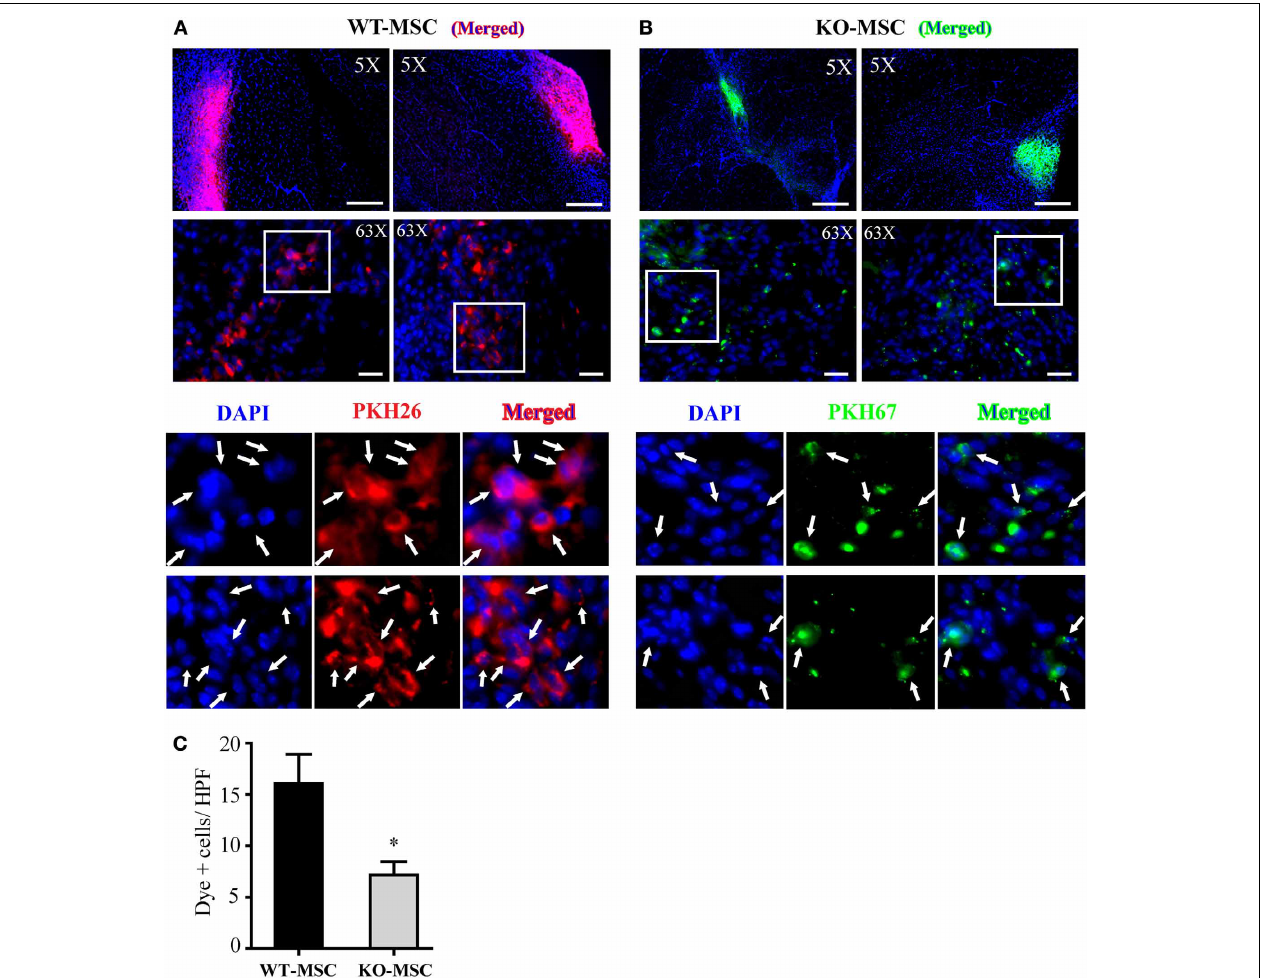
FIGURE 7 | Engraftment of MSCs in vivo . Representative images of localized PKH26 (red) labeled WT-MSCs (A) and PKH67 (green) labeled KO-MSCs (B) at 7 days after cell injection. (C) Quantification